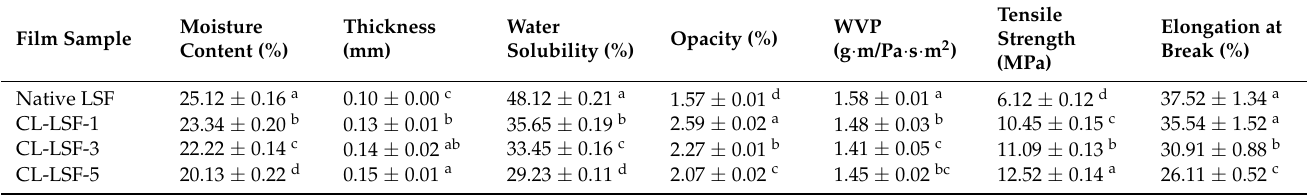
Table 4. Moisture content, thickness, water solubility, opacity, water vapor permeability, and mechan- ical properties of native and cross-linked lotus seed starch